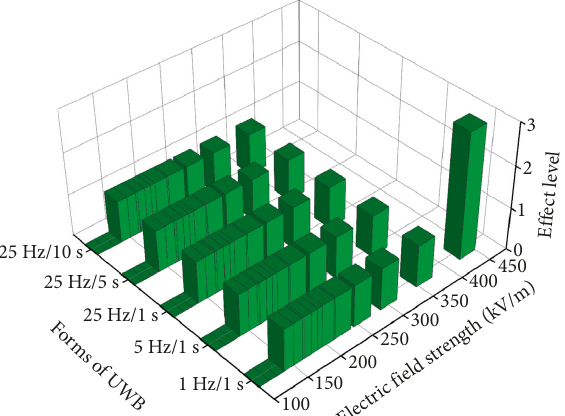
Figure 22: Test data of detector